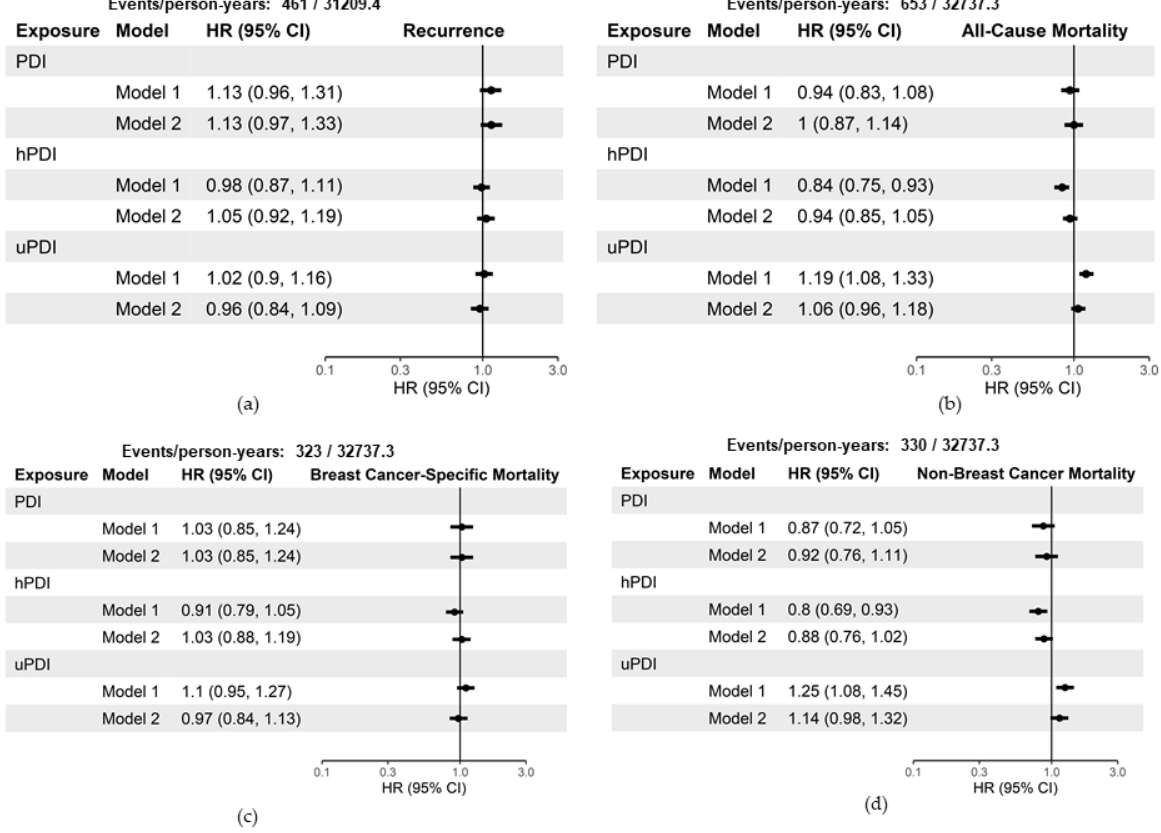
Figure 2. Hazard ratios and 95% confidence intervals for a 10-unit increase in baseline measurements of plant-based indices with breast cancer recurrence and survival among 3646 breast cancer survivors, Pathways Study. Model 1 adjusted for the following covariates: age at diagnosis, total energy intake (kcal/d), and physical activity (moderate-vigorous MET-hours/week). Model 2 adjusted for the following covariates: Model 1 covariates, race/ethnicity, education, menopausal status, smoking status, and stratified by tumor stage and ER status: ( a ) includes estimates of the hazard of recurrence; ( b ) estimates of the hazard of all-cause mortality; ( c ) estimates of the hazard of breast-cancer-specific mortality; ( d ) estimates of the hazard of non-breast-cancer mortality. CI = confidence interval; HR = hazard ratio; PDI = plant-based diet index; hPDI = healthful plant-based diet index; uPDI = unhealthful plant-based diet index.